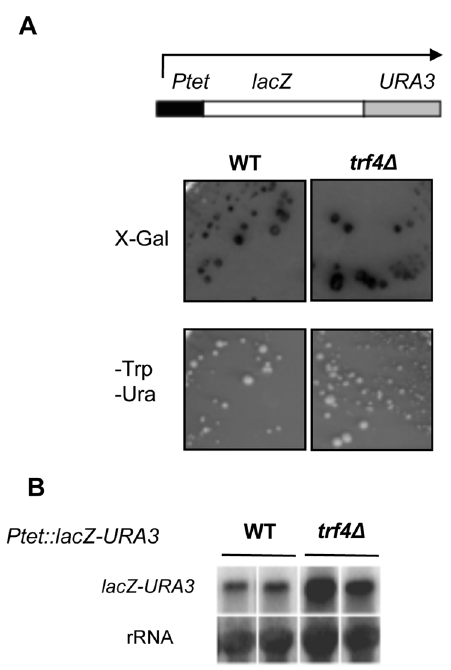
Figure 3. Transcription analysis of the trf4 D strain. ( A ) Analysis of the ability of W303-1A and TRF4D-C5 ( trf4 D ) strains carrying the Ptet::lacZ-URA3 (LAUR) fusion construct (plasmid pCM184-LAUR) to form colonies on SC-trp-ura medium and to form blue colonies on SC-Trp complemented with X-Gal. ( B ) Northern analysis of the expression of the Ptet::lacZ-URA3 . RNA was isolated from two different mid-log phase cultures from each strain, grown in SC-trp. We used the 3-kb Bam HI lacZ fragment and an internal 589-bp 25S rDNA fragment obtained by PCR, as probes.